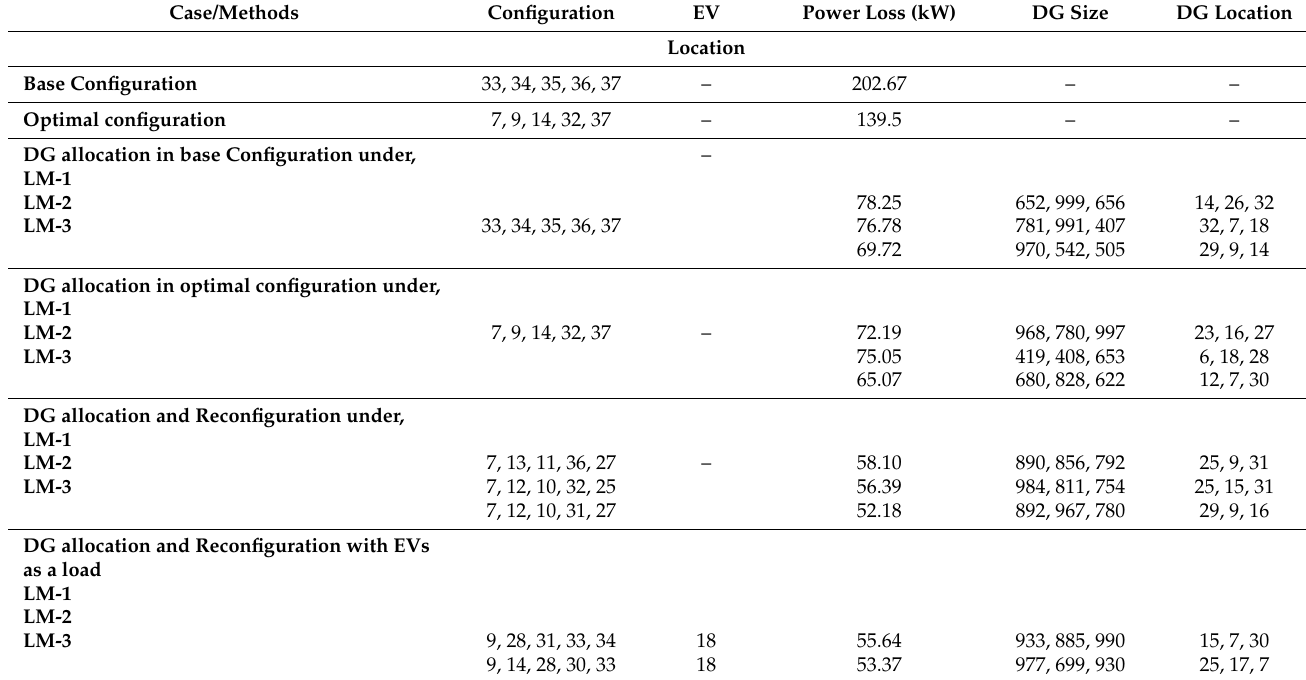
Table 11. Comparison of different approaches for 3-DG allocation and power loss